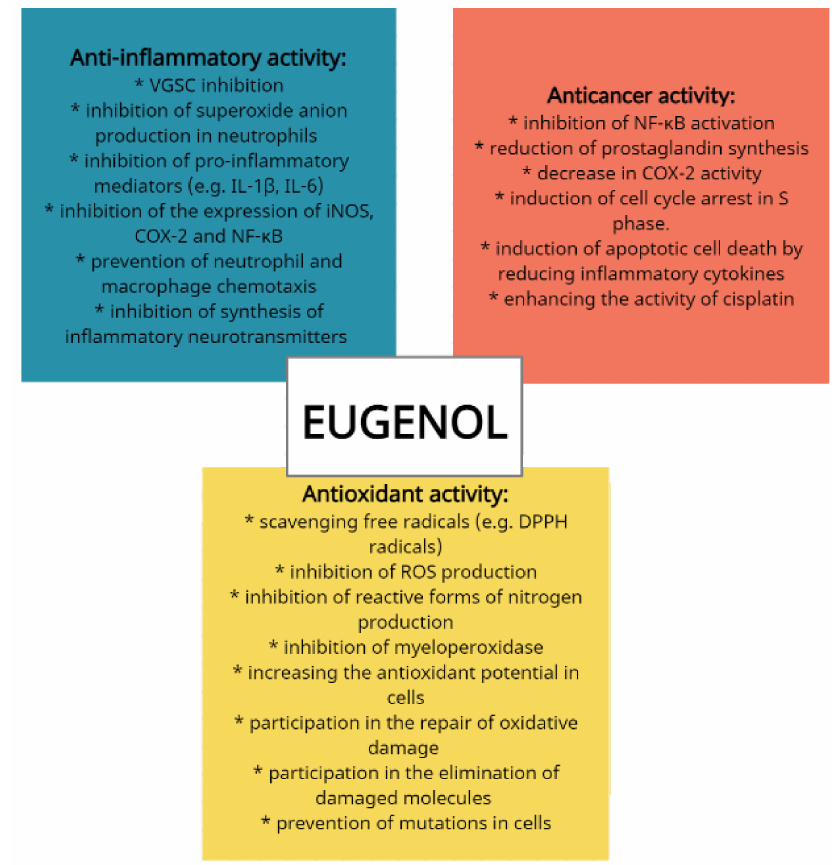
Figure 3. The anticancer, anti-inflammatory, and antioxidant mechanism of action of eugenol